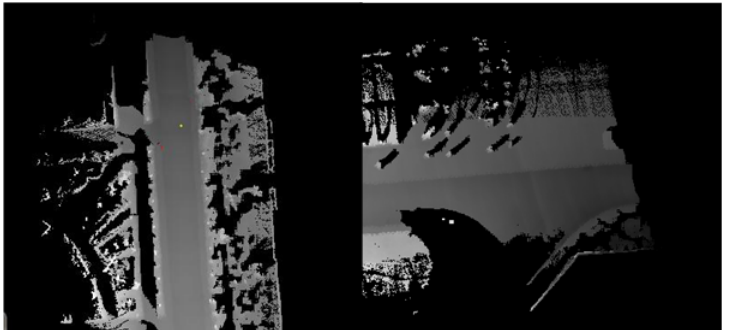
Figure 10. Digital Elevation Map from LiDAR data